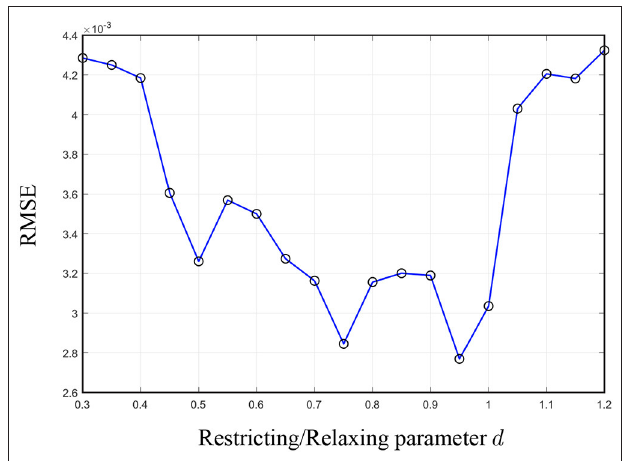
FIGURE 8 | Root mean square error (RMSE) of VSEKF considering variation of parameters d (Restricting/Relaxing parameter).